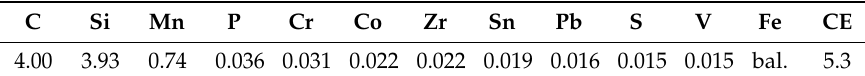
Table 1. Chemical composition in wt %.